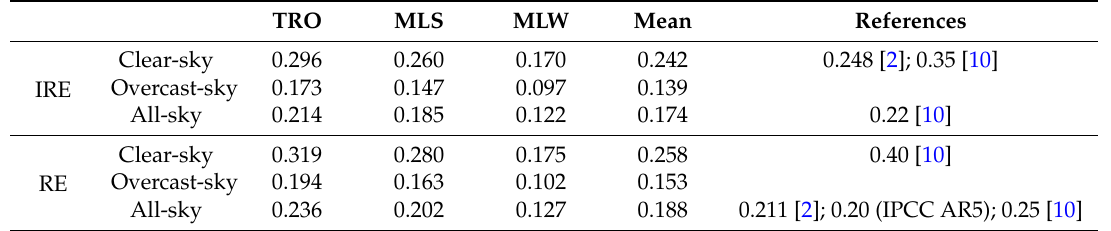
Table 3. NF 3 instantaneous radiative efficiency (IRE) and radiative efficiency (RE) from the LBLRTM and from other works are compared. TRO, MLS, and MLW refers to tropical, mid-latitude summer, and mid-latitude winter model atmospheric profiles, respectively. TRO MLW